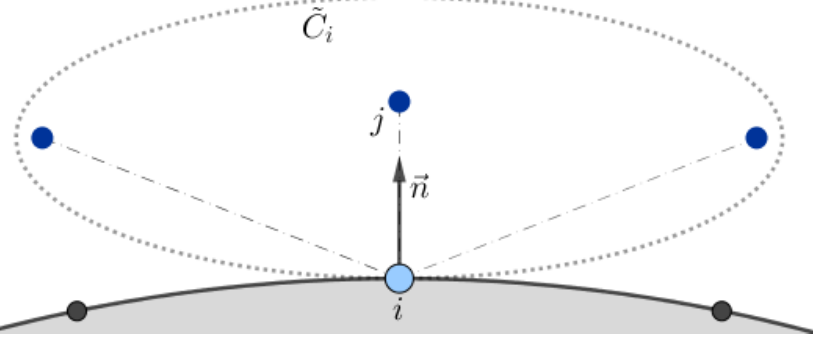
Figure 3. Implementation of the boundary conditions on the body surface.